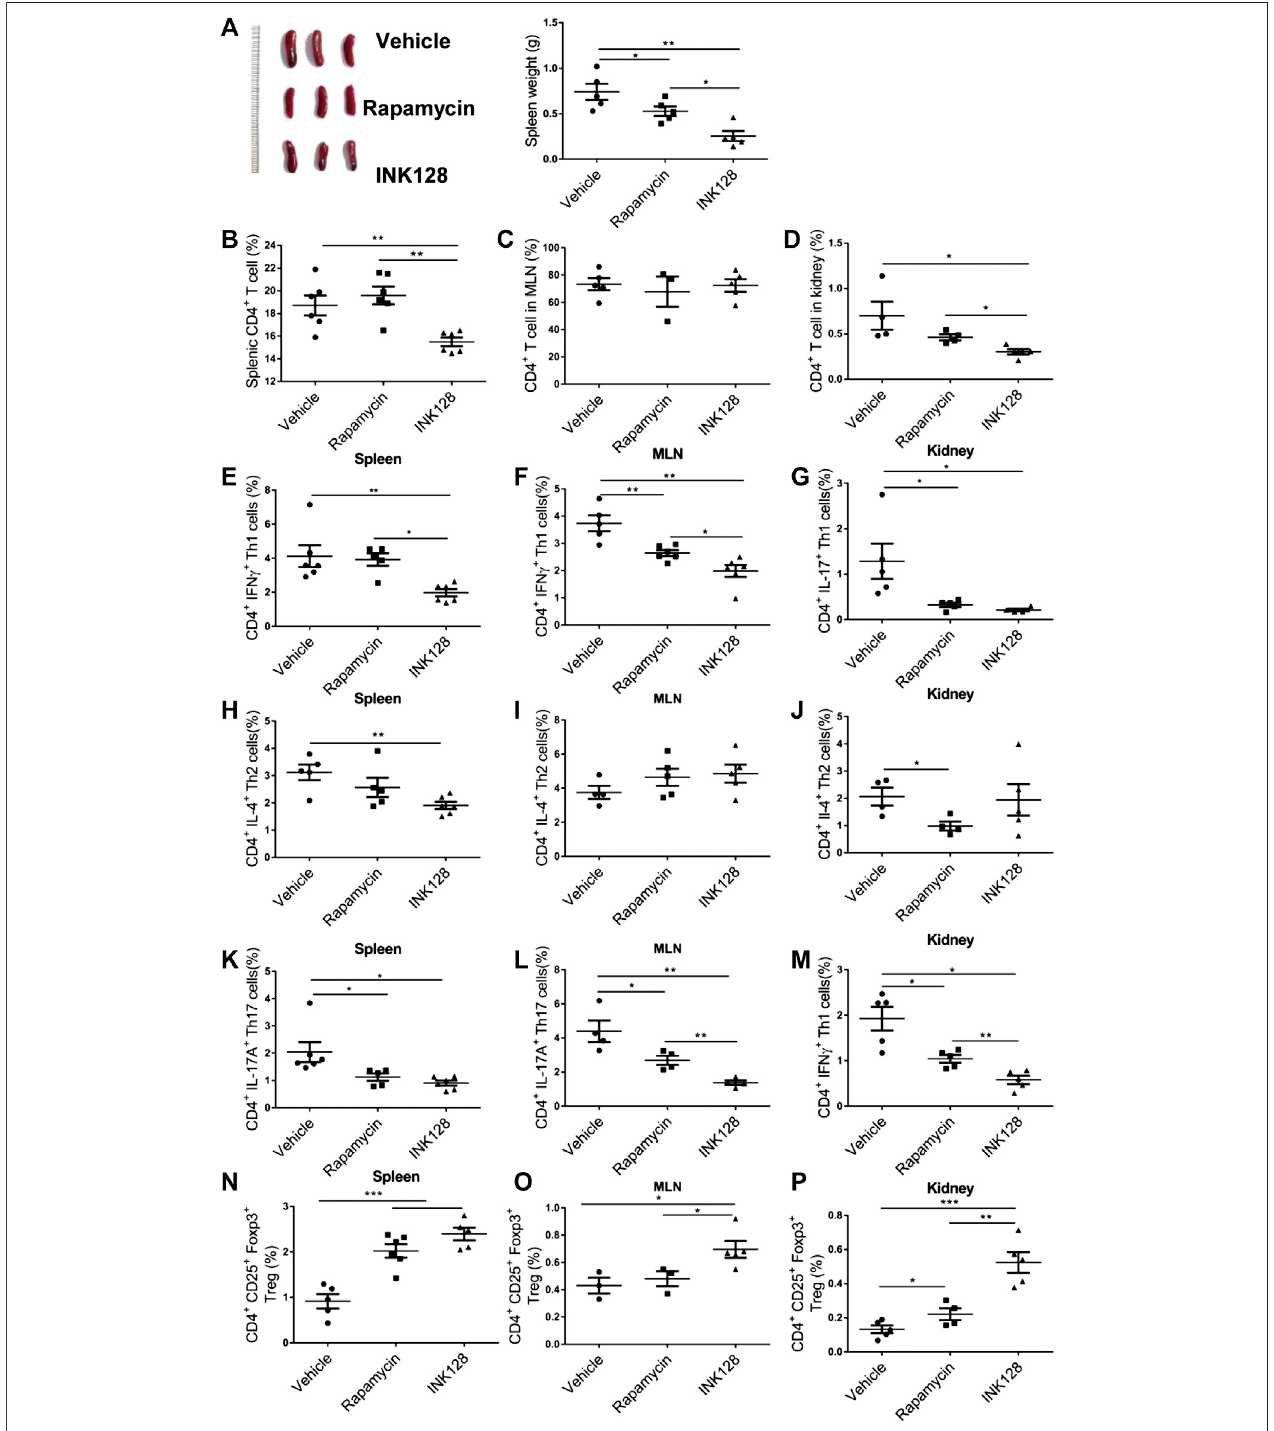
FIGURE 3 | Immunomodulatory effects of INK128 treatment on T cell populations in MRL/lpr mice. (A) Representative photographs of spleens from each group (left).Weightofspleensfromeachgroups.Dataarerepresentativeorarethemedian ± interquartilerangefrom5or6independentexperimentswithonemicepergroupin each experiment. (B – D) The percentage of CD4 + T cells in spleens, MLN and kidney were analyzed by fl ow cytometry (n (cid:2) 6). (E – G) The percentage of CD4 + IFN γ + Th1 cells in spleens, MLN and kidney were analyzed by fl ow cytometry. Data are representative or are the median ± interquartile range from 5 or 6 independent experiments with one mice per group in each experiment. (H – J) The percentage of CD4 + IL-4 + Th2 cells in spleens, MLN and kidney were analyzed by fl ow cytometry. Dataarerepresentativeorarethemedian ± interquartilerangefrom5or6independentexperimentswithonemicepergroupineachexperiment. (K – M)